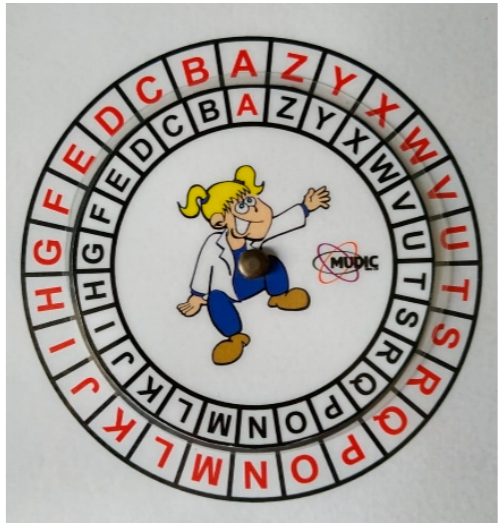
Figure 3. Students encrypting with the scytale.